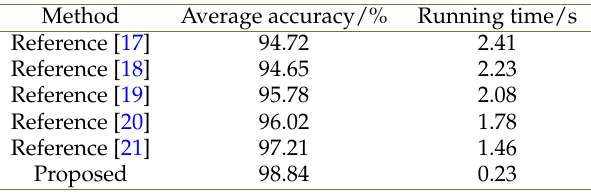
Table 5. Comparison of average accuracy and running time with different